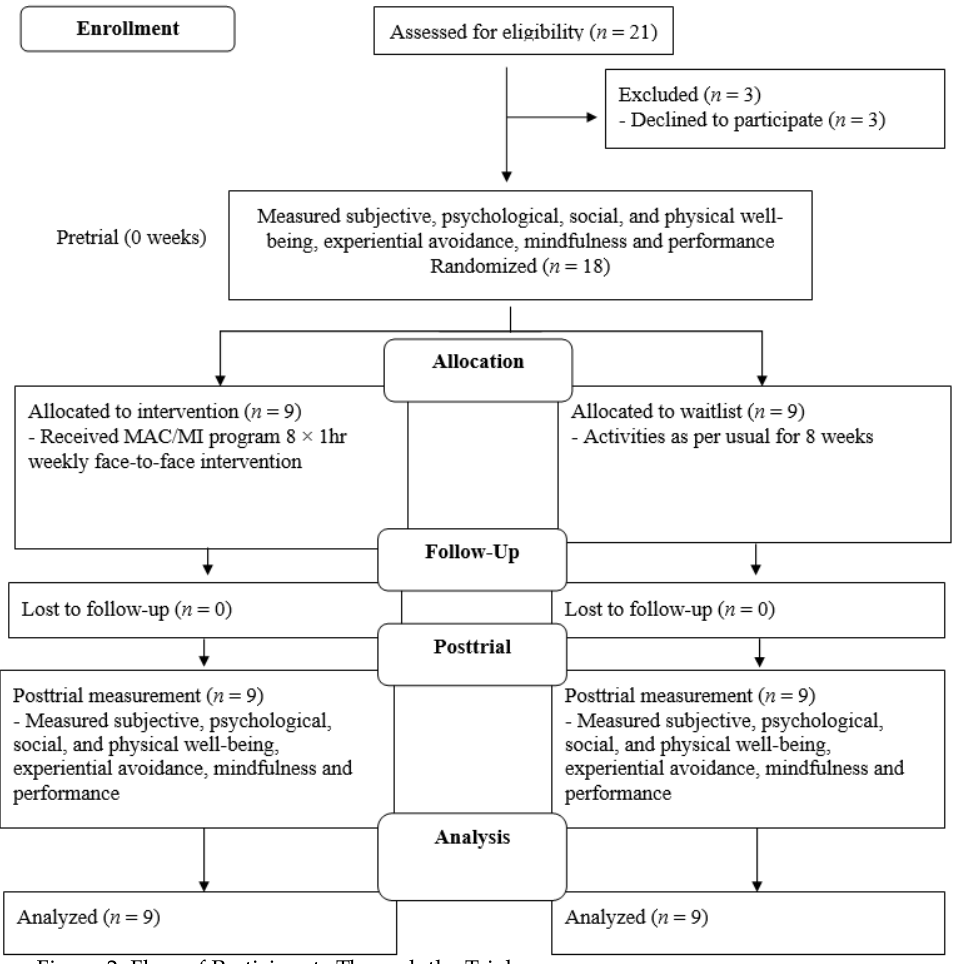
Figure 2. Flow of Participants Through the